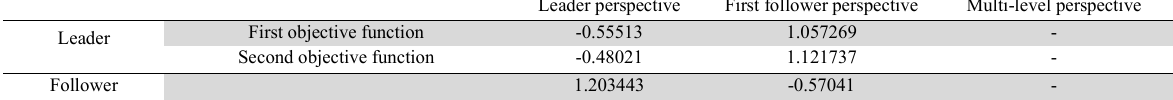
Percentage of decrease provided by the bi-level model for the second three